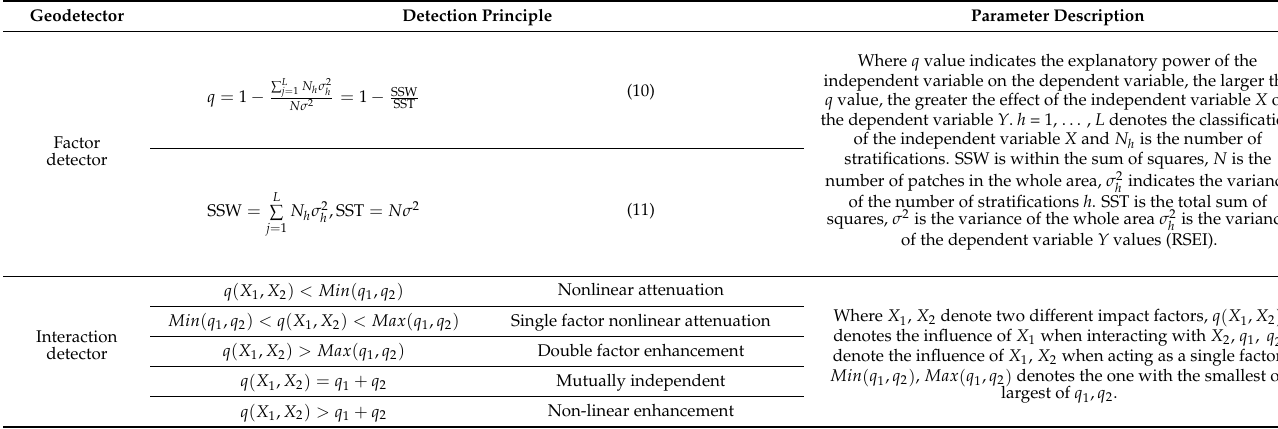
Table 6. Geodetector principle and